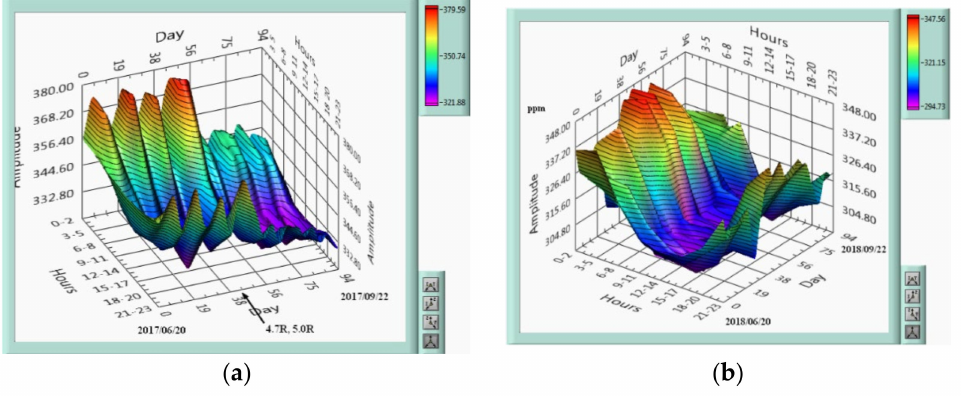
Figure 9. CO 2 in Nehoiu summer: ( a ) 2017; ( b ) 2018.